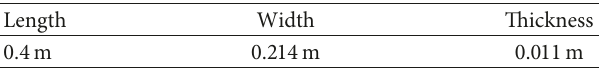
Table 7: Geometry parameters of the composite plate.